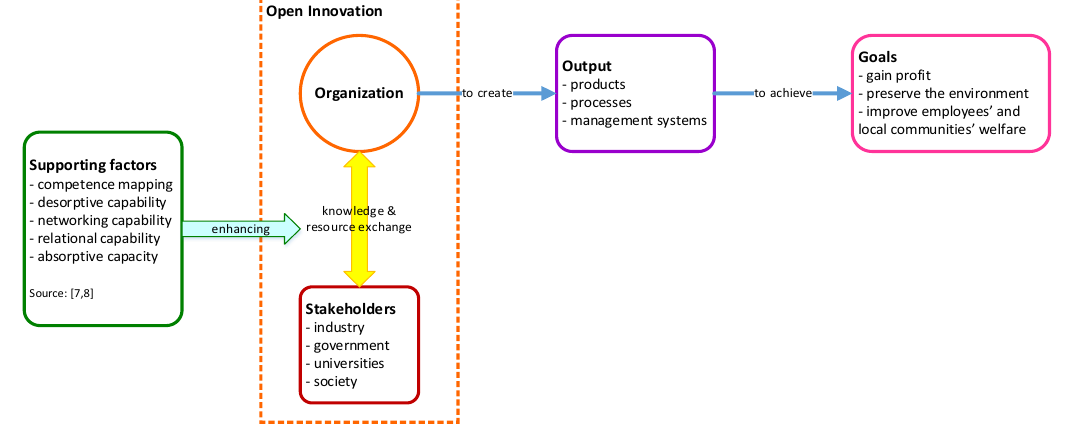
Figure 2. Sustainability-oriented open innovation.